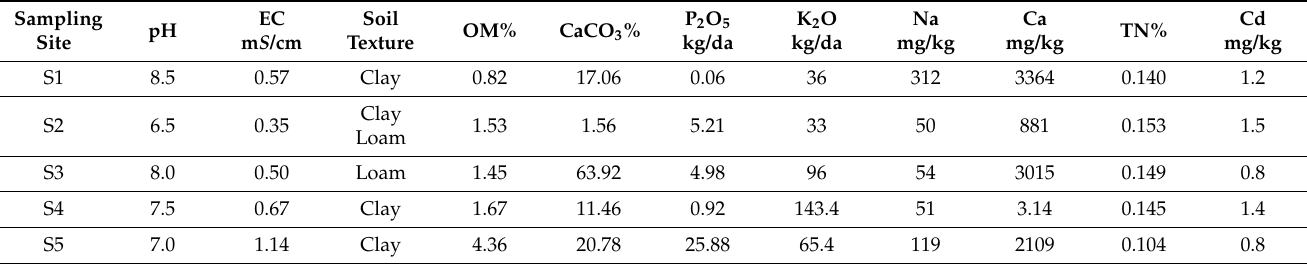
Table 3. Physicochemical properties of soil samples.